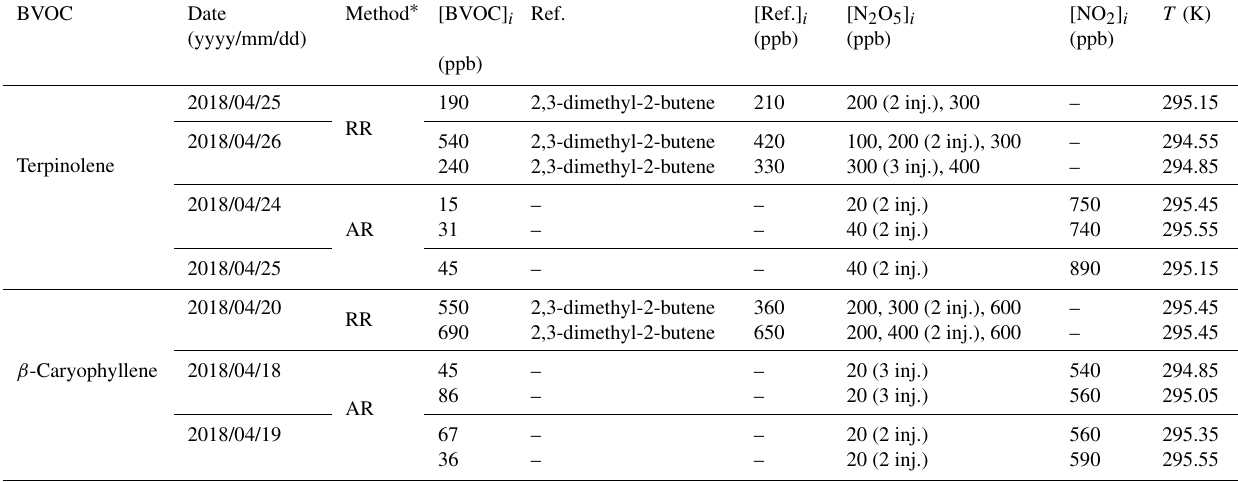
Table 1. Experimental conditions of kinetic experiments. [BVOC] i and [Ref.] i are the initial mixing ratios of the BVOC and of the reference compound. For [N 2 O 5 ], the number of punctual injections is indicated in parentheses. T is the mean temperature inside the simulation chamber during the